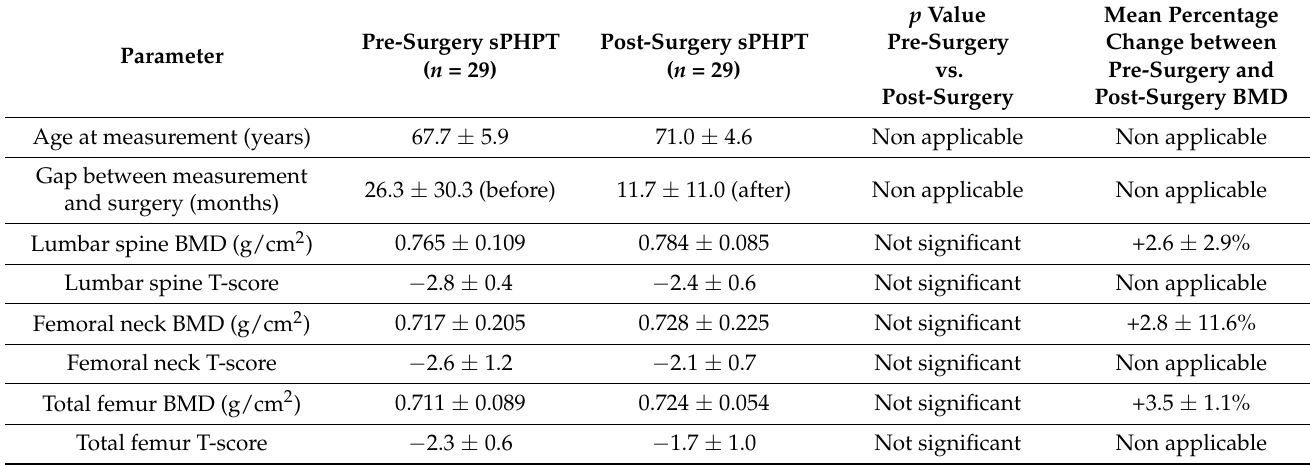
Table 6. Comparison of DXA parameters, measured before and after PTX, in